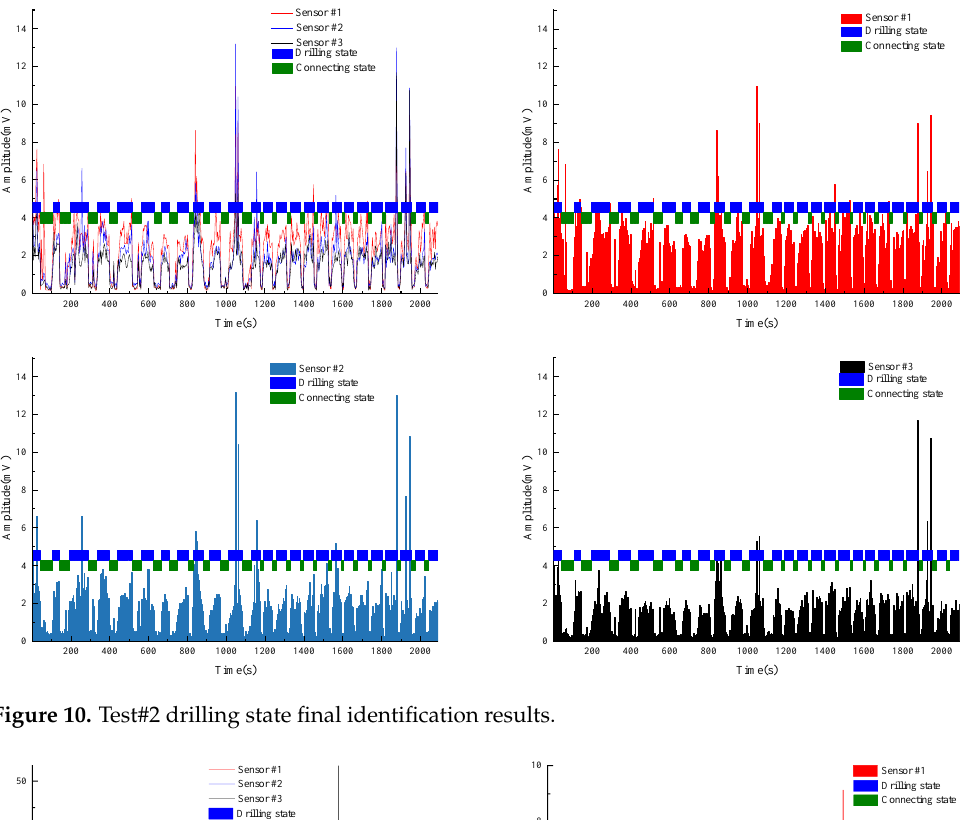
Figure 10. Test#2 drilling state final identification results.